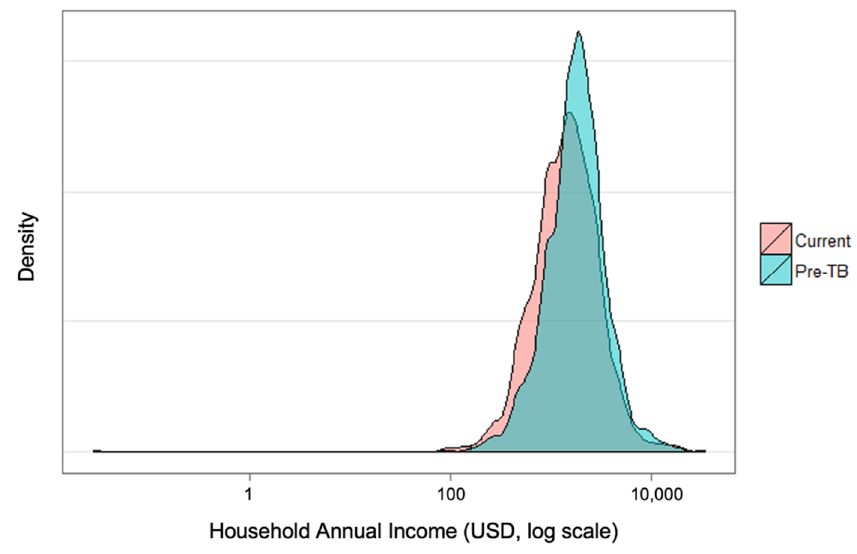
Figure 1. Distribution of annual household income pre-TB diagnosis and at time of survey, in 2015 USD.